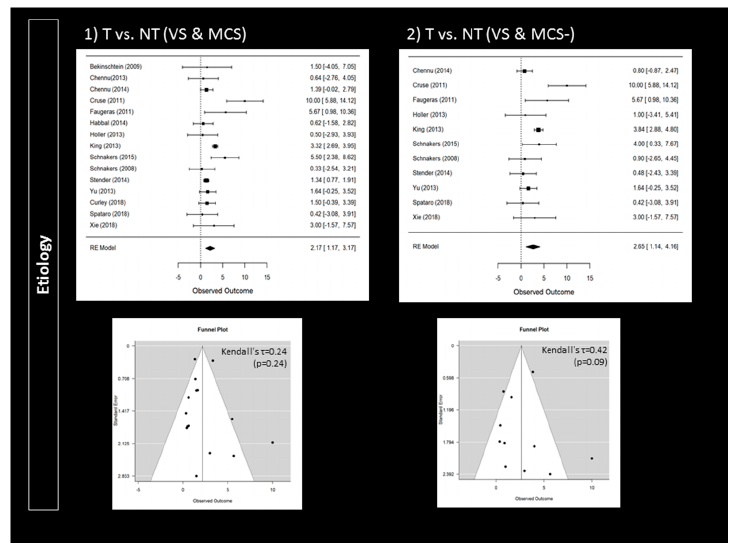
Figure 2. Impact of disorders of consciousness on the rate of responders: forest plots and publication bias (Funnel plots and Kendall’s tau). An observed outcome (and confidence interval) above 0 means MCS > VS (for Panel 1) or MCS − > VS (for Panel 2). Brain Sci. 2020 , 10 , x FOR PEER REVIEW